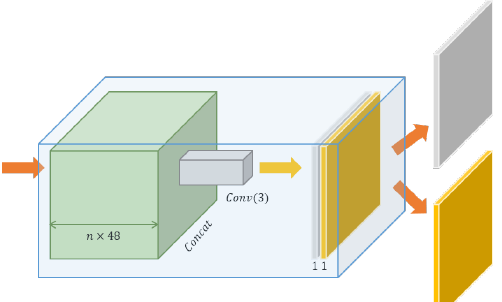
Figure 4. Visualization of the reconstruction module.